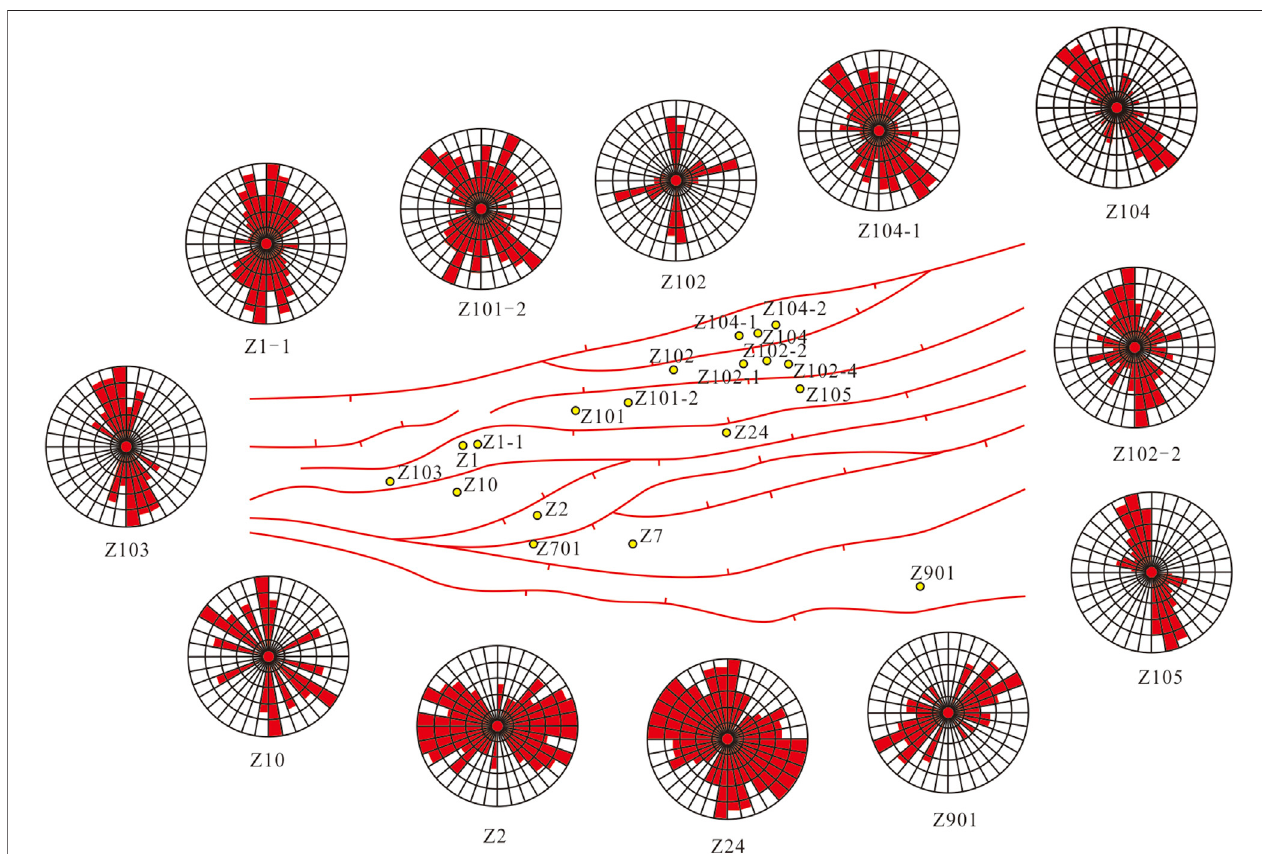
FIGURE 7 | Stereographic of fracture strike of typical well in the Bozi gas fi eld.